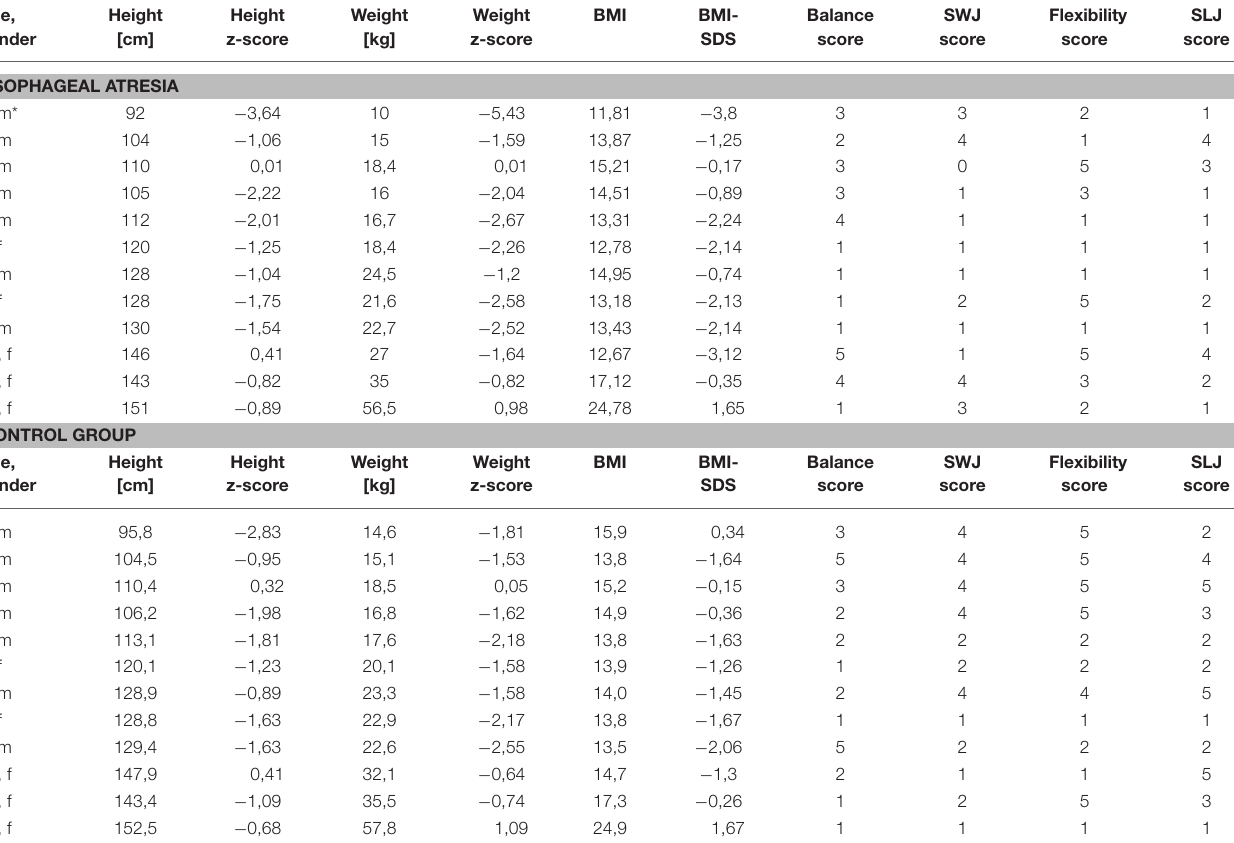
TABLE 1 | Participants and Test scores according to KTT/ DMT and matched controls (1 = PP 1–20, 2 = PP 21–40, 3 = PP 41–60, 4 = PP 61–80, 5 = PP 81–100), PP = performance percentile, SWJ = sideways jump, SLJ = standing long jump, BMI = Body-Mass-Index, BMI-SDS = body-mass-index standard-deviation-score, m = male, f = female, *outlier.